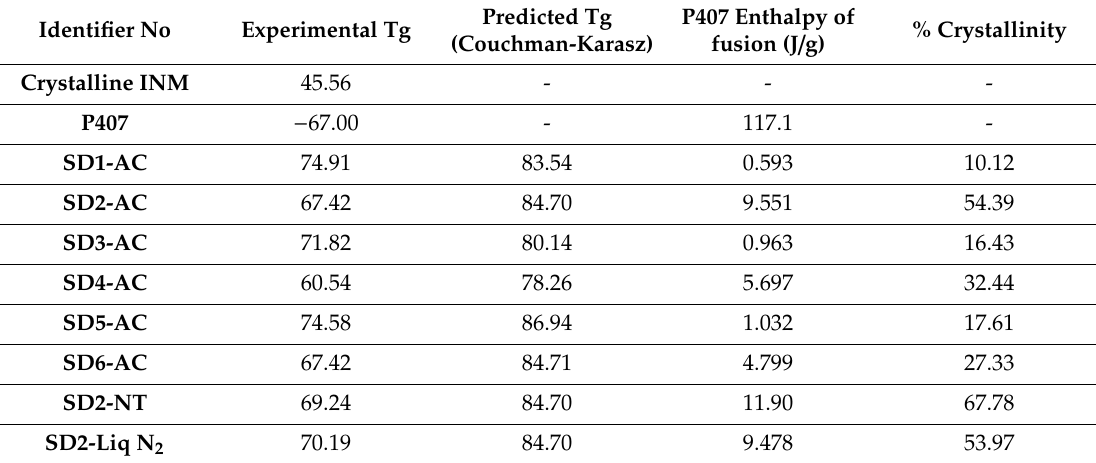
Table 7. Experimental T g , Predicted T g , P407 enthalpy of fusion (J / g) and % crystallinity of various SD formulations and selected SD formulations used to investigate the e ff ect of cooling on the solubility of